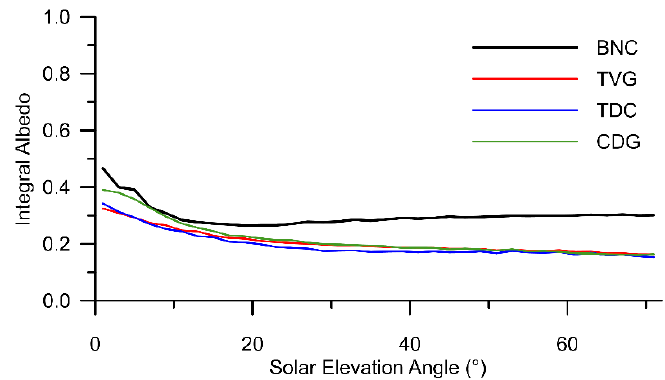
Figure 6. Integral albedo coefficients as a function of solar elevation angle for all the sites.